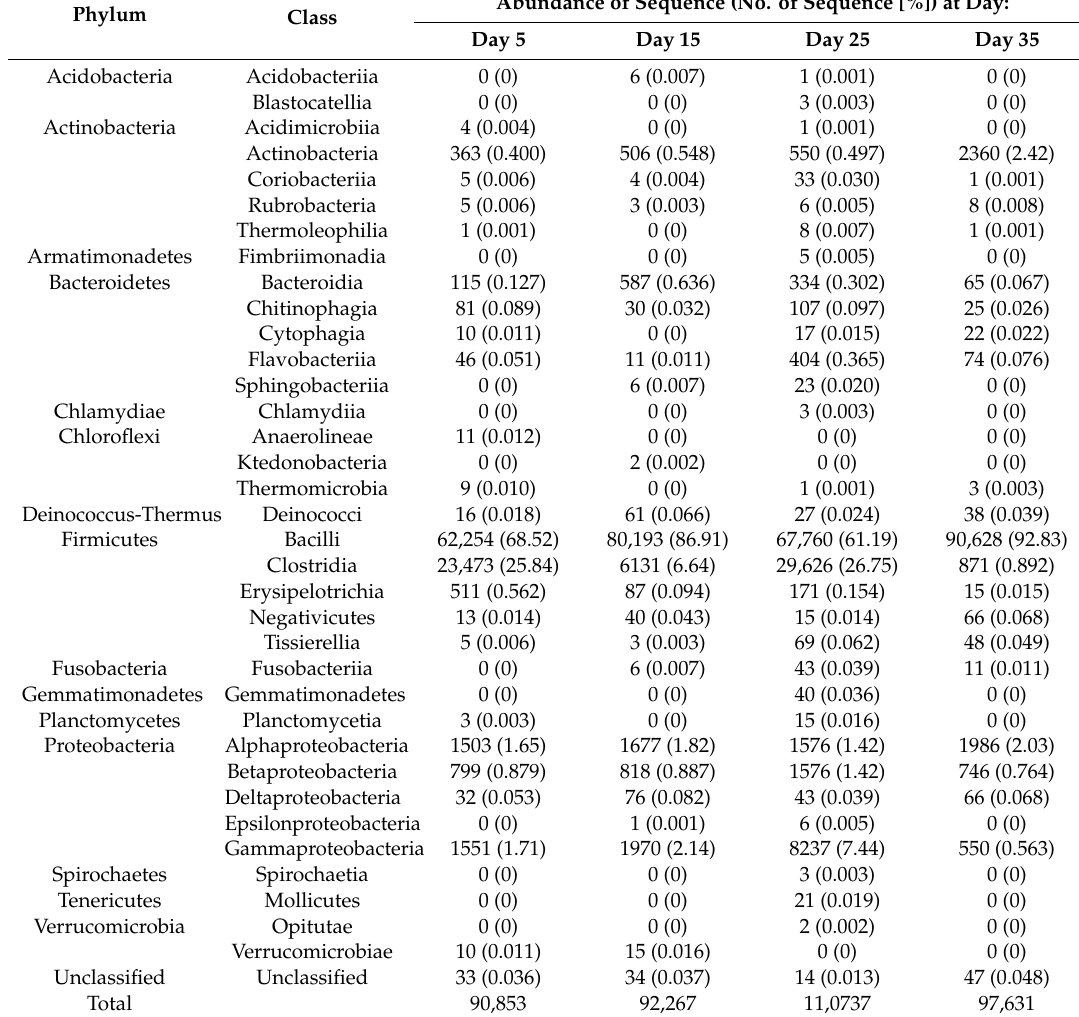
Table 7. Abundance of bacterial 16S rDNA sequences ( n = 391,488) isolated from the duodenum microbiota of local Omani